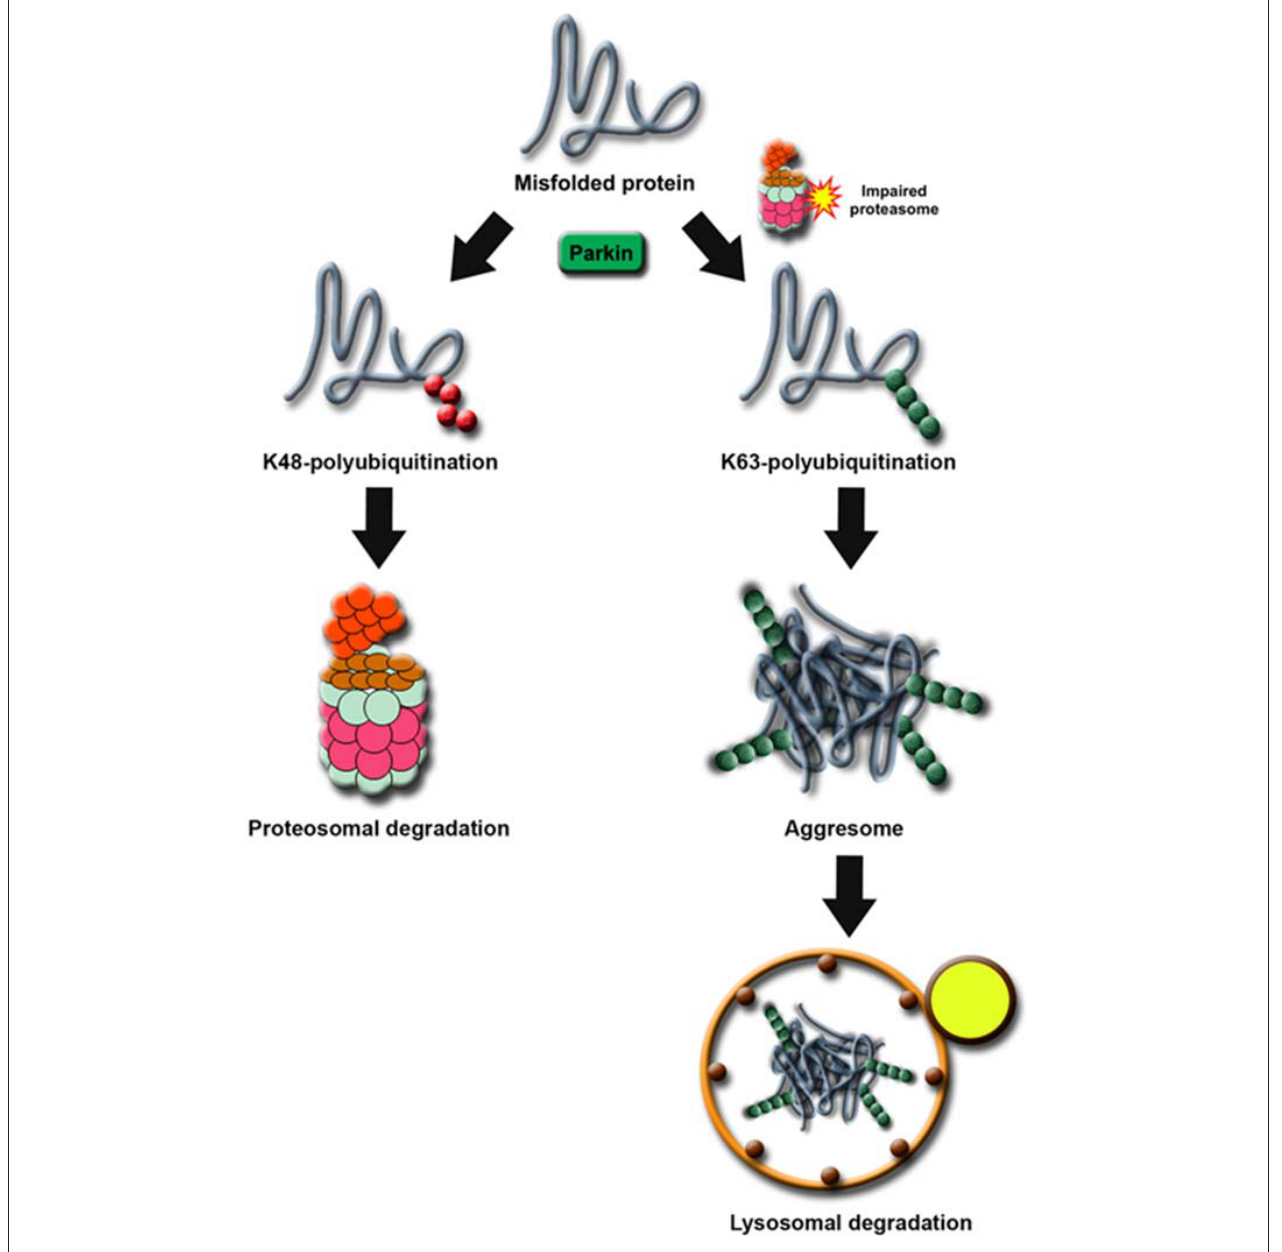
FIGURE 2 | Proposed model of Parkin’s role as a triage between proteasome and autophagy degradation . Under normal cellular conditions, proteins destined for degradation by the proteasome are tagged with a chain of K48-linked ubiquitin. In times of proteolytic stress, the cell switches to K63-linked ubiquitination to divert the protein load originally targeted for proteasomal degradation away from the otherwise overloaded machinery. Parkin facilitates this switch by increasing its affinity for Ubc13 in the presence of proteasome